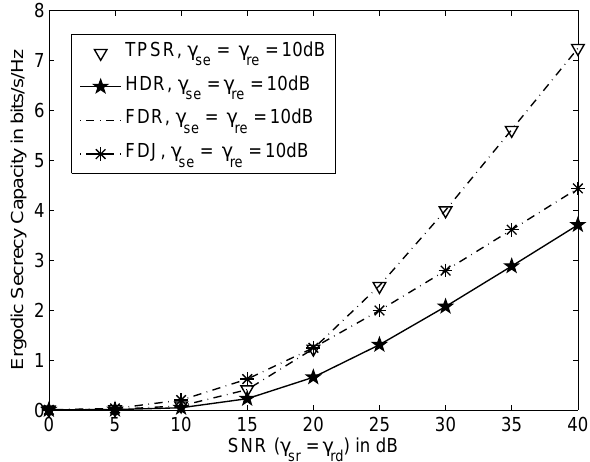
Figure 2. Ergodic achievable secrecy rate versus SNR where γ sr = γ rd , γ se = γ re = 10dB and the inter-relay interference or self-interference, γ rr = 0dB.